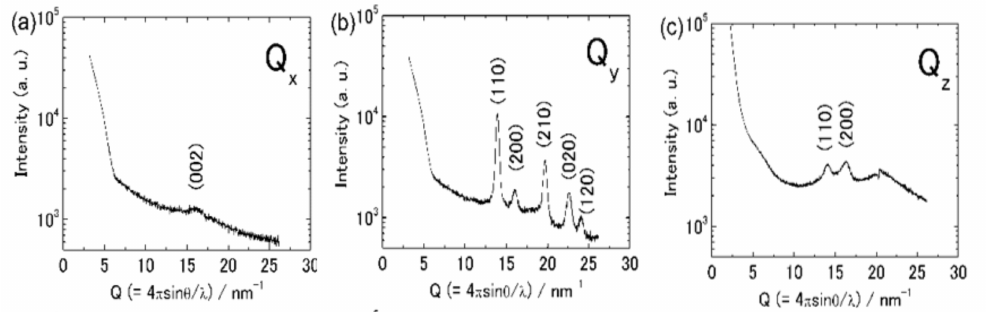
Figure 6. XRD profiles of friction-transferred PT film in reciprocal space Qx ( a ), Qy ( b ) and Qz ( c ). The direction of Qx is parallel to the film surface and parallel to the drawing direction. That of Qy is parallel to the film surface and orthogonal to the drawing direction. That of Qz is normal to the film surface.